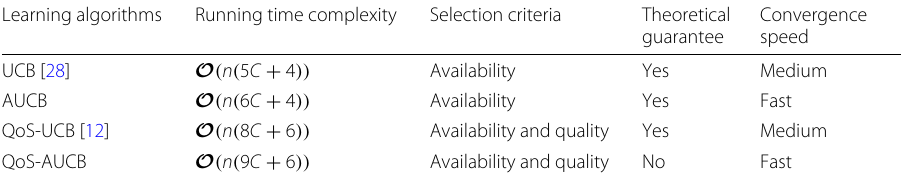
Table 2 Algorithms complexity Learning